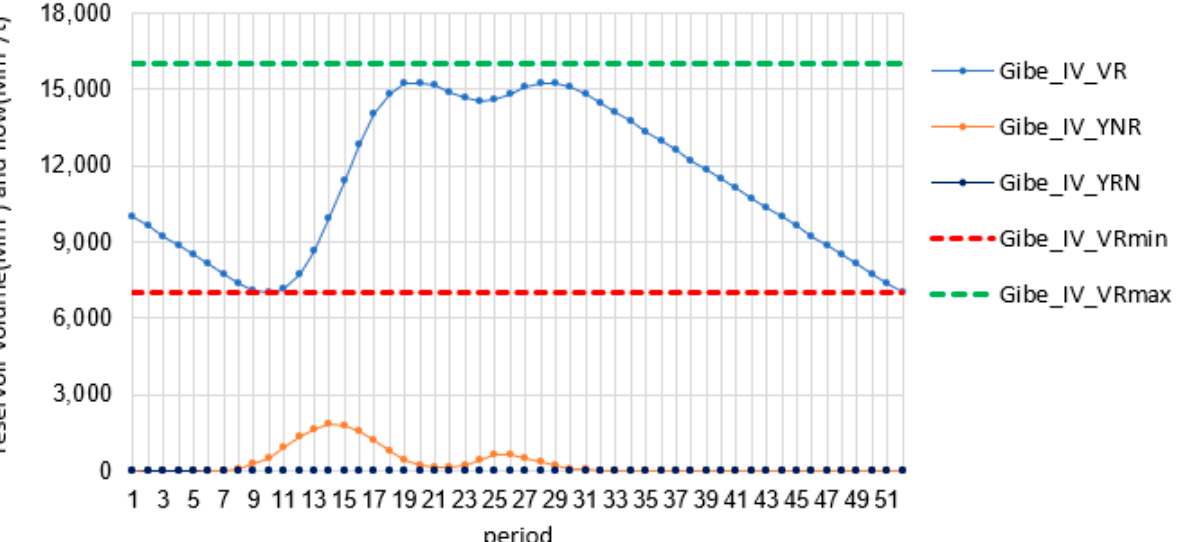
Figure 22. Gibe IV reservoir water volume storage and inflow/outflow model simulation results.